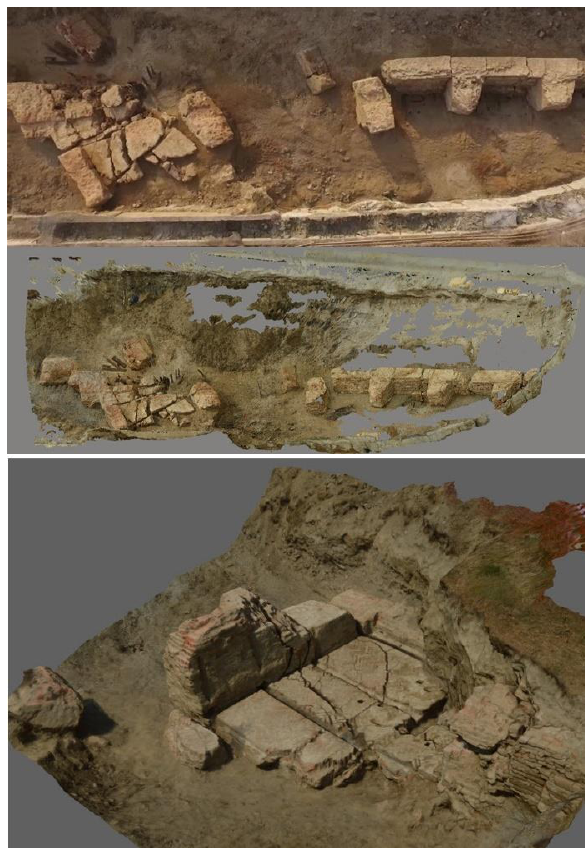
Figure 8. Above: plan of the archaeological remains (blue existent structures, red hypothesized structures, light brown wooden structures). Below: reconstruction of the ancient mill based on the plan obtained from the archaeological